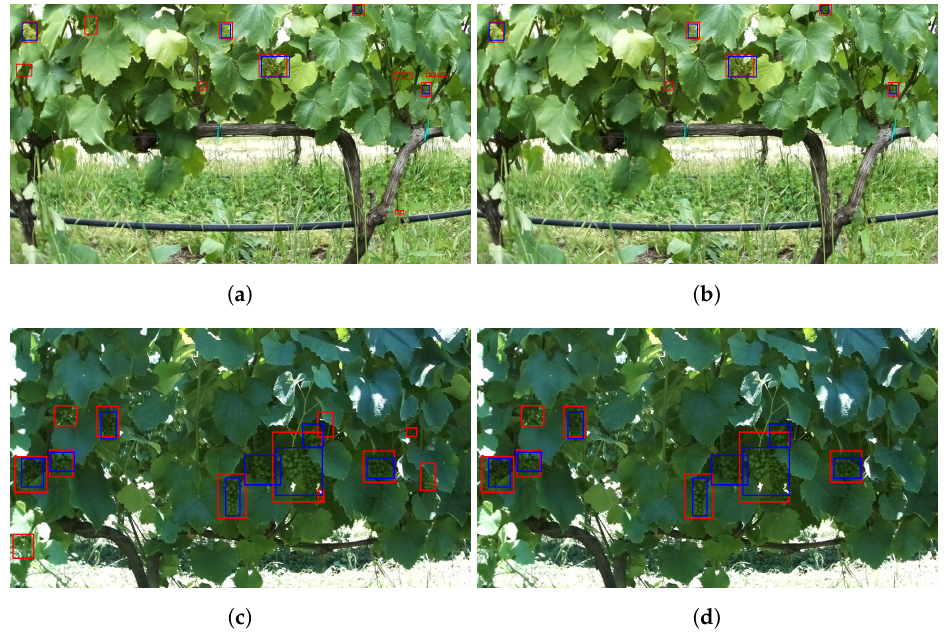
Figure 9. Impact of the confidence score on the final detection results. Blue bounding boxes represent the ground truth and the red ones the SSD MobileNet-V1 detections considering a confidence score of ( a , c ) 20% and ( b , d ) 50%. Table 5. Grape bunch detection performance considering a confidence of 50% and a variation of the IoU threshold for three different